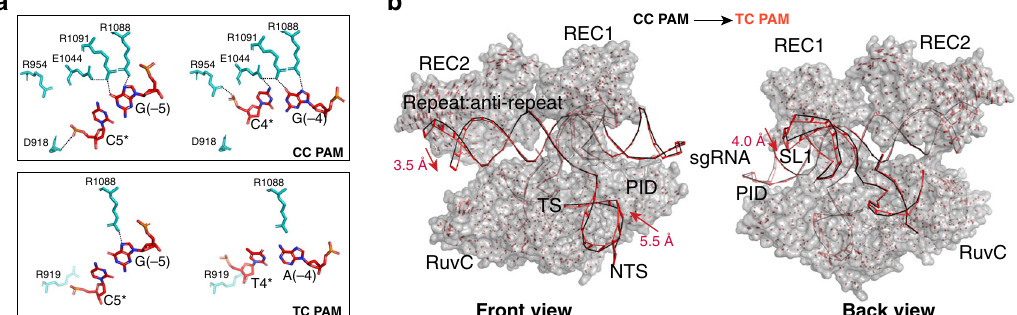
Fig. 6 Crystal structure of AceCas9 – Δ HNH – sgRNA – DNA (C4*T) complex. a Detailed comparison of PI-PAM interactions between the 5 ′ -NNNCC-3 ′ (CC PAM) and the 5 ′ -NNNTC-3 ′ (TC PAM) complex. AceCas9 residues within 3.6 Å of the four PAM nucleotides are shown in teal color. Dashed lines indicate the close contacts among the protein residues and between the protein and the PAM nucleotides. Note the signi fi cantly fewer number of residues in the TC PAM complex (bottom) than that in the CC PAM complex (top). b Comparison of the overall structures between the 5 ′ -NNNCC-3 ′ (CC PAM) and the 5 ′ - NNNTC-3 ′ (TC PAM) complex. Pair-wise difference vectors were computed for the carbonyl carbon (for proteins) and the phosphate atoms (for RNAs) between the two structures and displayed as red bars on the wild-type structure in surface (protein) and ribbon (nucleic acids) representations. Nucleic acids are shown in both complexes and are colored black (CC PAM) and red (TC PAM), respectively. Labels of domains and RNA secondary elements are de fi ned as in Fig.